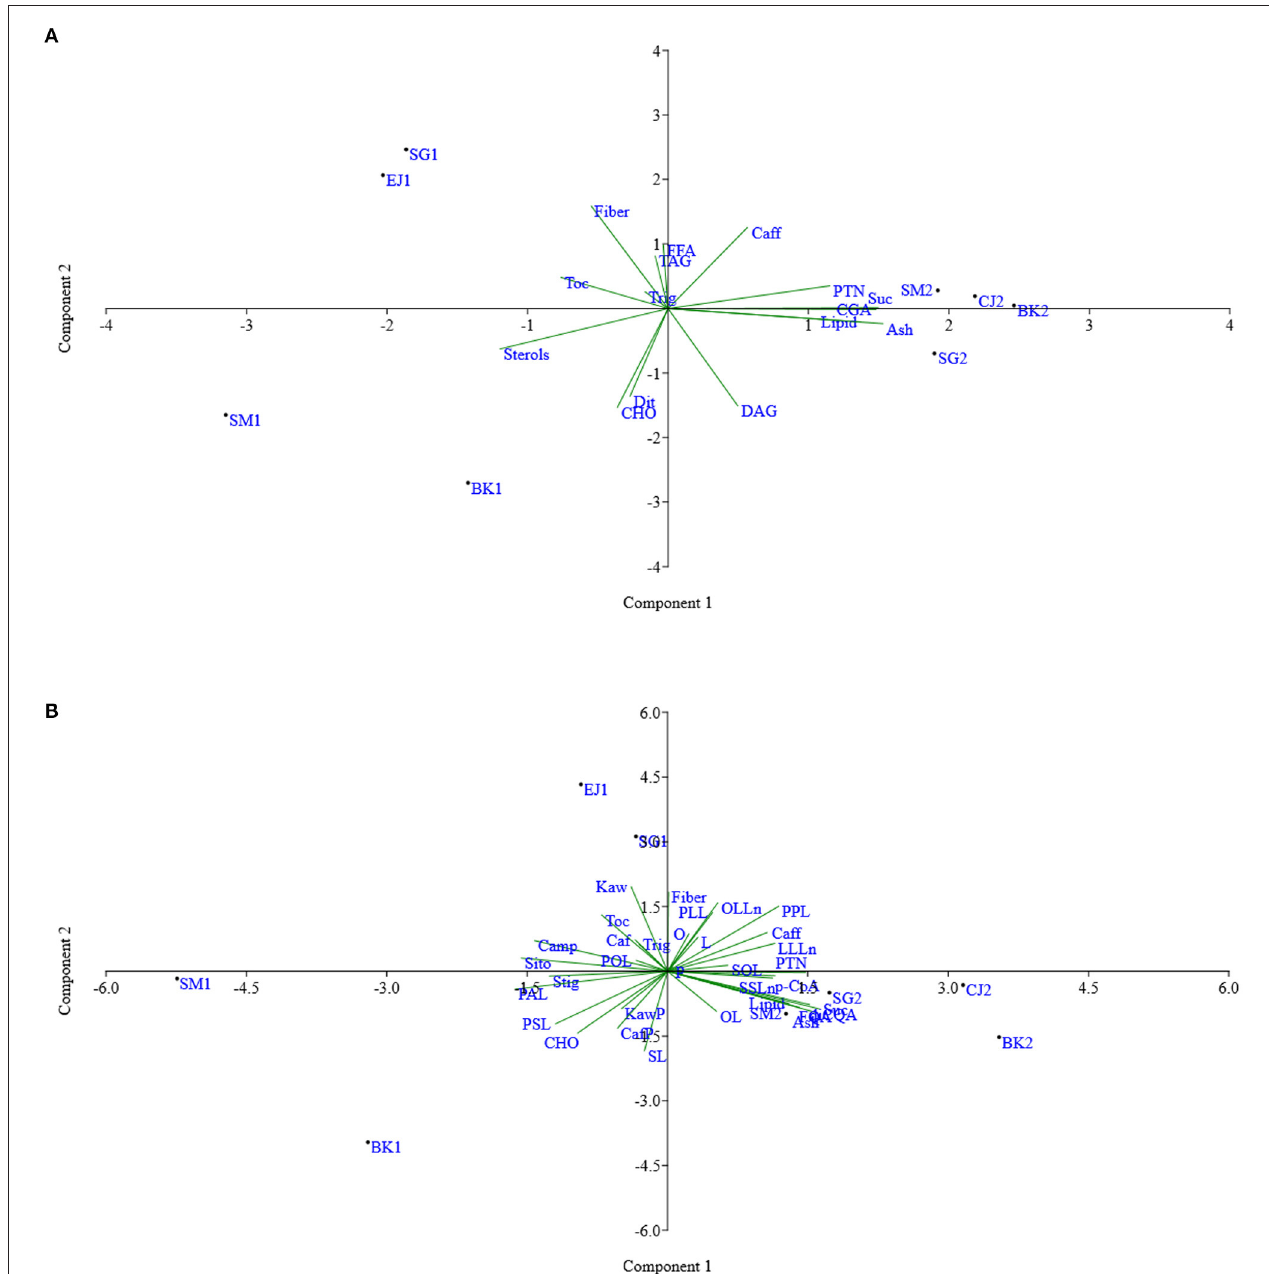
FIGURE 7 | Principal component analysis (PCA) concerning the distribution of grouped compounds of Kopi Luwak (SG, Sumatra Aceh Gayo; SM, Sumatra Mandheling; EJ, East Java; CJ, Central Java; BK, Bali Kintamani) coffee samples from crops 1 (2015) and 2 (2017) (A) or in relation to all measured individual (B) . PTN, Protein; CHO, Carbohydrates; Caff, Caffeine; Trig, Trigonelline; Suc, Sucrose; Dit, Diterpenes; CGA, Chlorogenic acids; FFA, Free fatty acids; DAG, Diacylglycerols; TAG, Triacylglycerols; P, palmitic; O, oleic; L, linoleic; S, stearic; A, arachidonic; Ln, linolenic; Kaw, Kaweol; Caf, Cafestol; Toc, β -Tocopherol; Camp, Campesterol; Sito, γ -Sitosterol; Stig, Stigmaesterol; KawP, Kahweol palmitate; CafP, Cafestol palmitate. 2017 samples compared to 2015 ones. Neither the harvesting ones, indicating that the crop year, in other words weather location nor the post-harvest processing have discriminated conditions, was a contributor to discriminating samples. The Kopi Luwak, as samples with equivalent characteristics (SG and most important contributors for the discrimination of these BK, for instance) were located in opposite quadrants of the samples were total lipids, ashes, total CGA, sucrose and PCA proteins, all of which were found at higher contents in